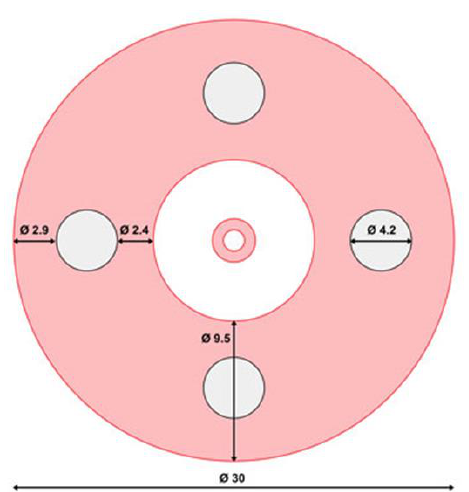
Figure 13. Schematic representation of vertical rings (dimensions in mm) .